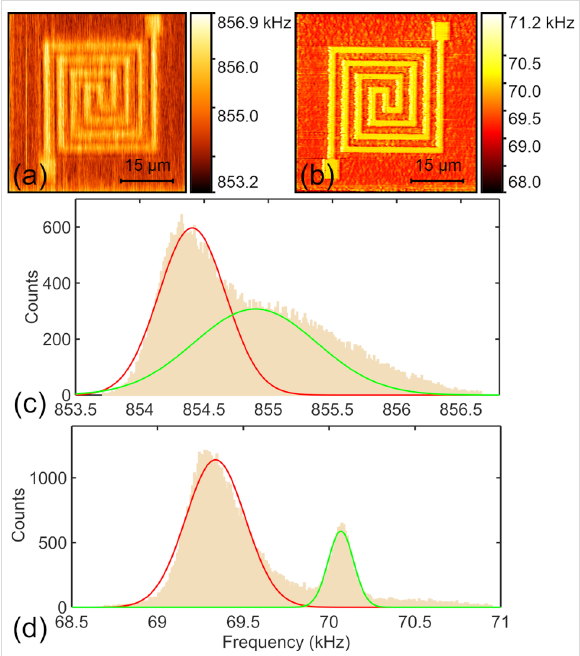
Figure 8: Optimization of CR-AFM subsurface imaging on a flexible circuit sample. (a,b) CR-AFM frequency images obtained before and after optimization, respectively. (c,d) Corresponding histograms of the images shown in (a) and (b). All the measurements were performed on the flexible circuit sample with a top layer thickness of 78 nm. For (a), the second mode of an ASYELEC-01 cantilever was used with an applied normal force of 398 nN. The image in (b) was obtained with the first mode of a ContAl-G probe under a tip-generated load of 613 nN.